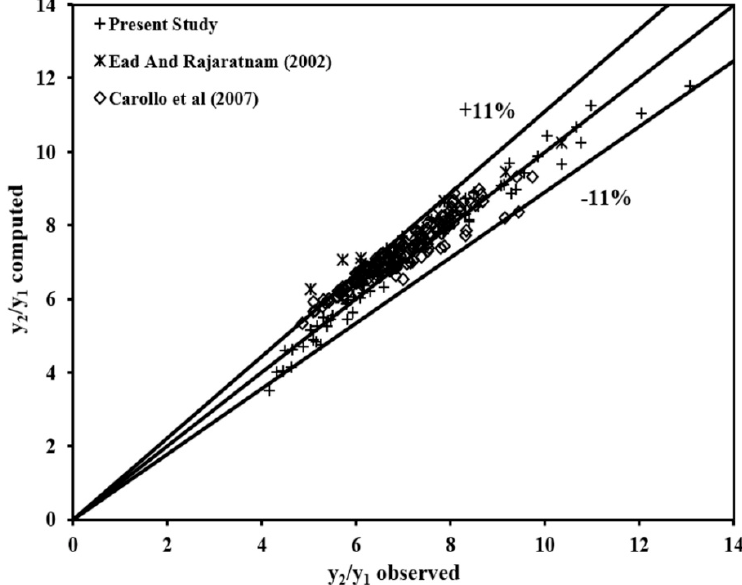
Figure 8. Comparison between the observed 𝑦 (cid:2870) 𝑦 (cid:2869) ⁄ values with those obtained by Equation (22).